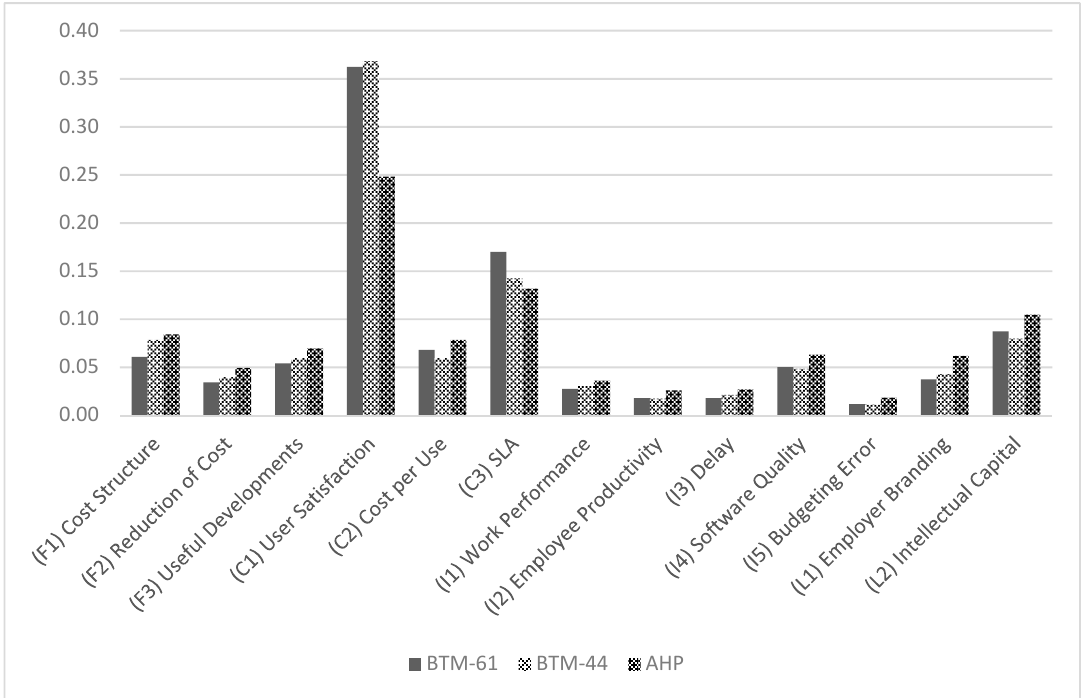
Figure 3. Sub-criteria (KPIs) weights chart comparing the Figure 3. Sub ‐ criteria (KPIs) weights chart comparing the models.